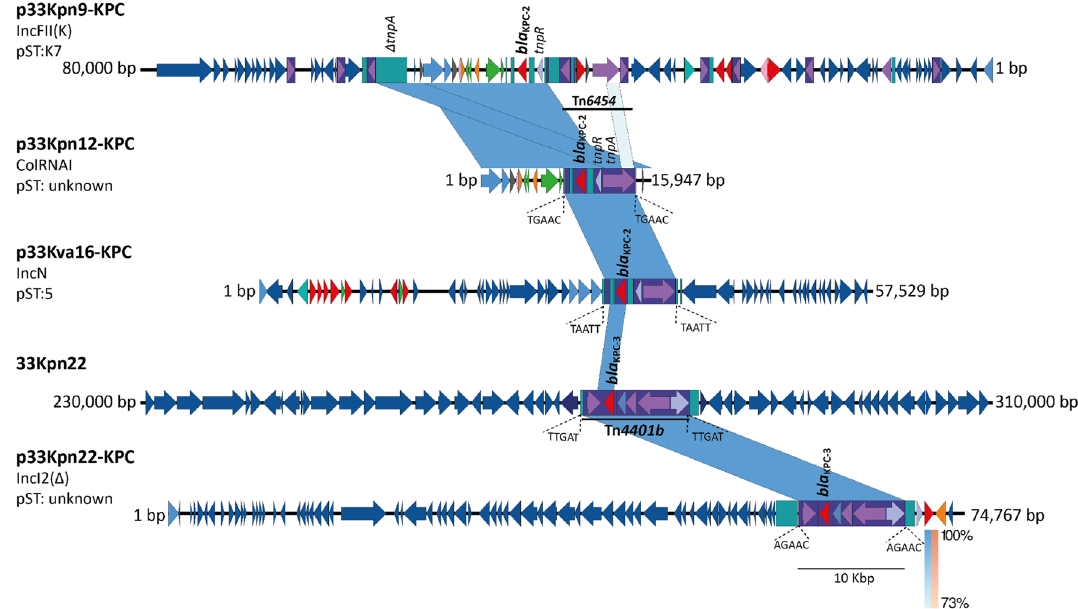
Figure 3. Comparative genomic analysis of Klebsiella sequences that harbored bla KPC gene isolated from patient 24. p33Kpn9-KPC (CP064297), p33Kpn12-KPC (CP062794), 33Kpn22 (CP069046) and p33Kpn22- KPC (CP069050) for K. pneumoniae , and p33Kva16-KPC (JAGTWT010000009) for Klebsiella variicola . The shaded area between the sequences delimits the alignment regions with a percentage identity ≥ 73%. The blue arrows indicate the open reading frames and, adjacent to the gene of interest, the coding regions for hypothetical proteins (gray), transposases (purple), resolvases (purple), resistance genes (red) are highlighted and delimited by a purple rectangle to transposons. The duplication sites (TSDs) generated by the transposition were illustrated and delimited in dotted lines for each mobile genetic element. The graph has a scale line of 10,000